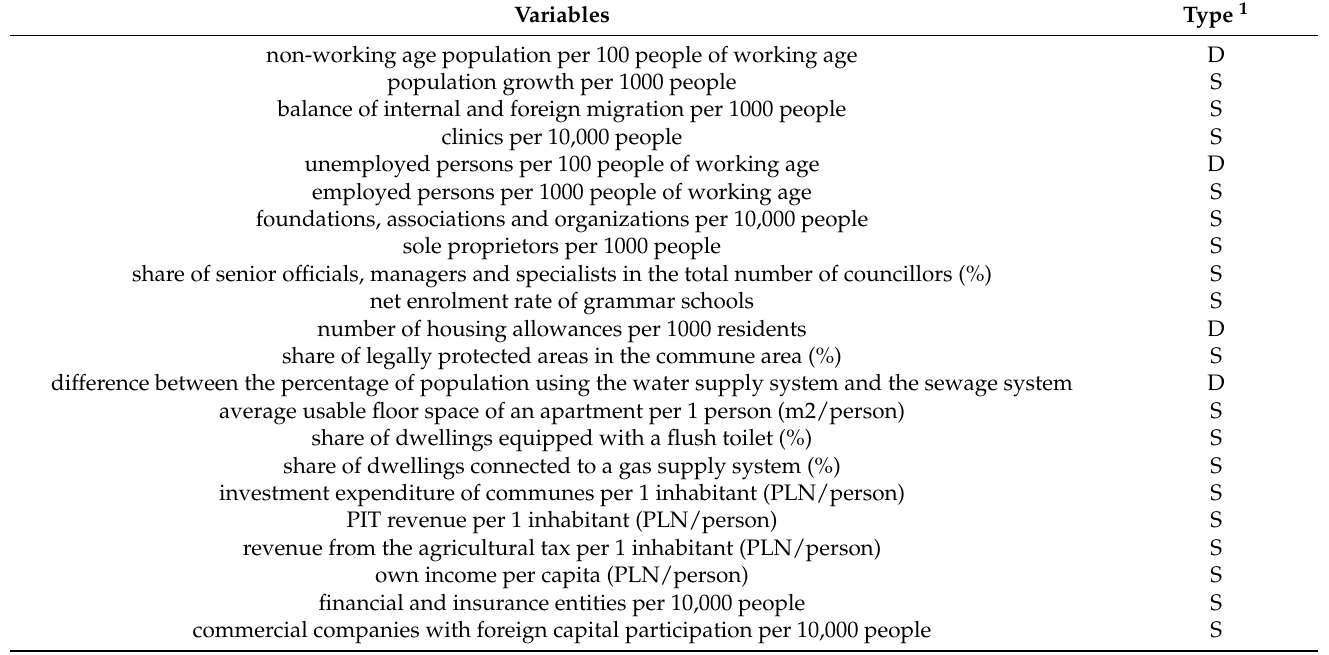
Table 1. Variables used to construct a synthetic index of socio-economic development. Source: own elaboration.